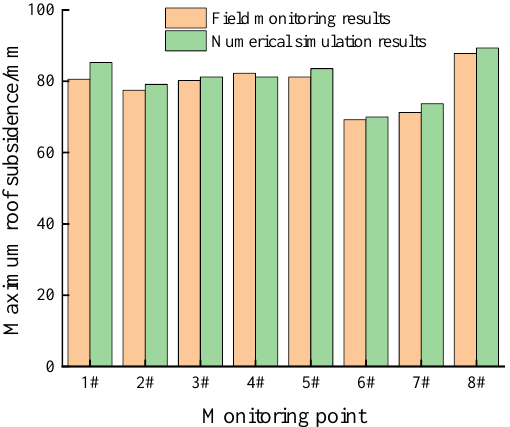
Figure 19. Numerical simulation results versus the field monitoring results of the maximum roof subsidence.